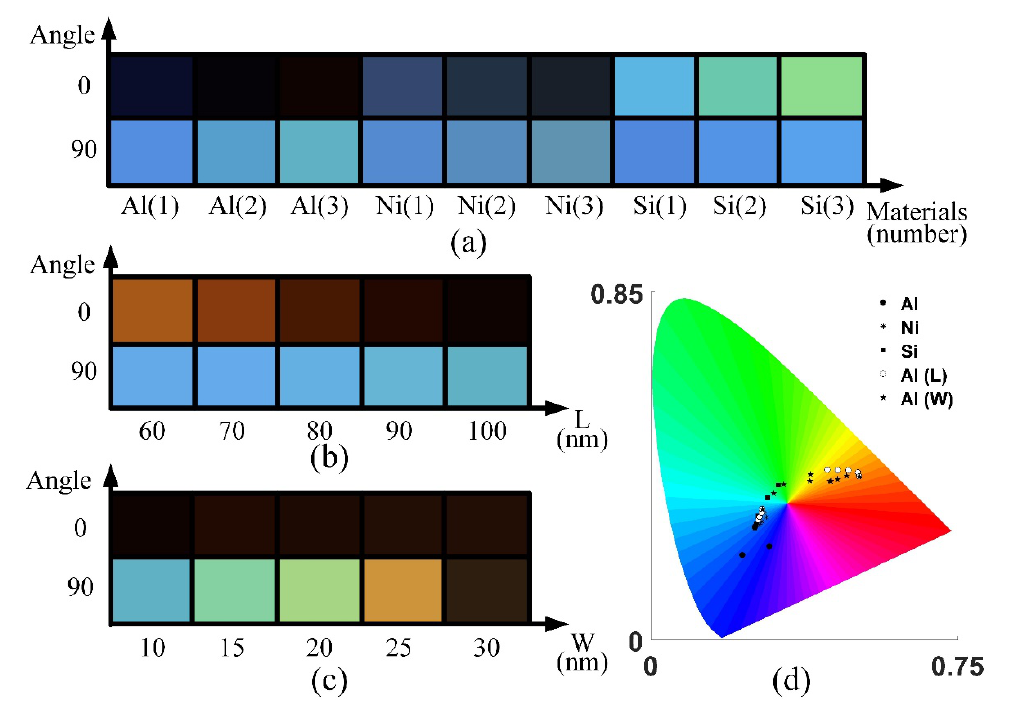
Figure 6. The relative electric field distribution diagrams in the cases of different materials and the number of material strips. ( a – c ) is Ni; ( d – f ) is Si. When there is subscript, the polarization direction is 90°.